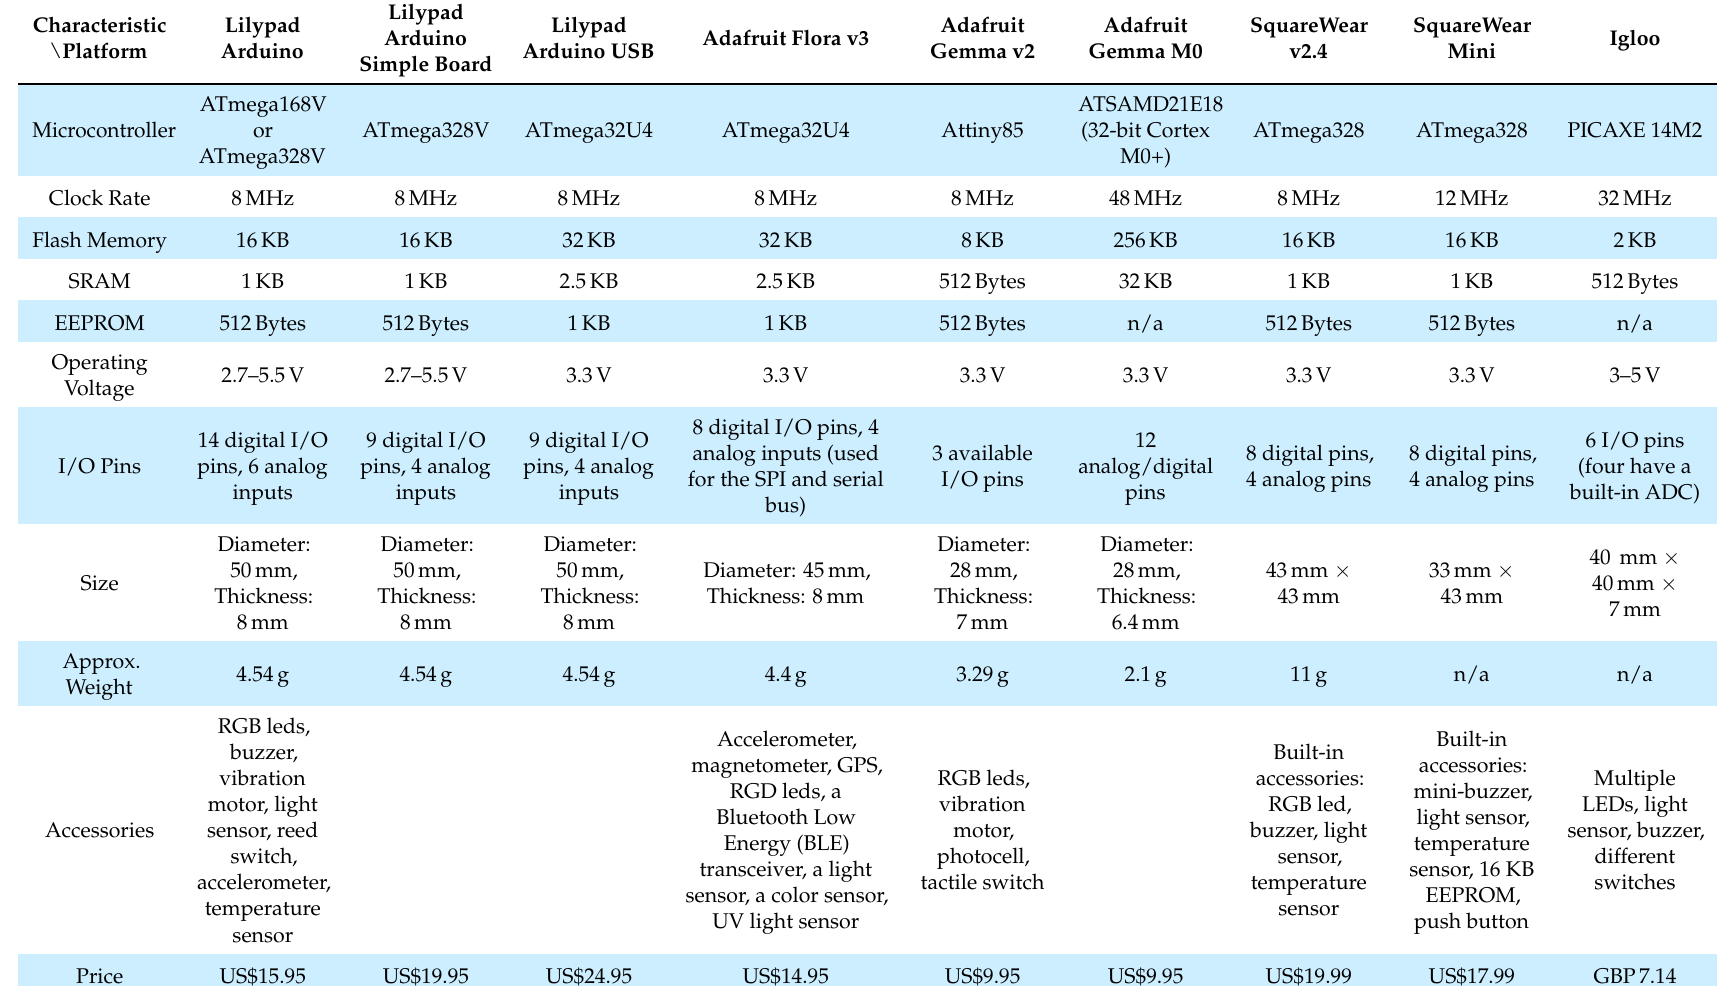
Table 1. Most popular DIY platforms for developing smart wearables and smart